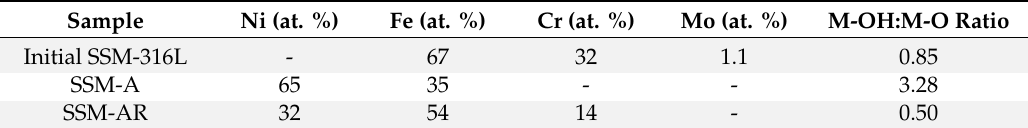
Table 1. Atomic percentages, normalized to total metal concentration obtained with XPS. The M-OH:M-O ratio is taken as the integrated intensity ratio between the two metal-oxides peaks in the O 1s spectral line with BE defined at 530.0 eV (M-O) and 531.5 eV (M-OH). Sample Ni (at. %) Fe (at.